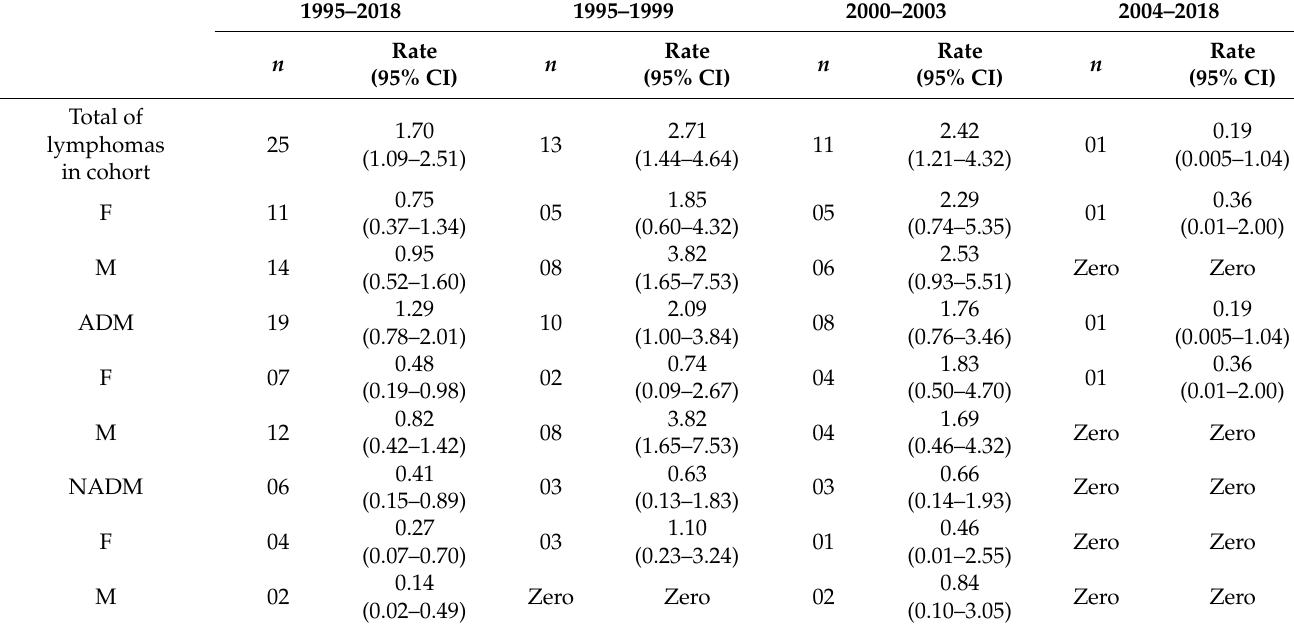
Table 2. Summary of the Epidemiologic Trends of Lymphoma Diagnosis (Lymphomas